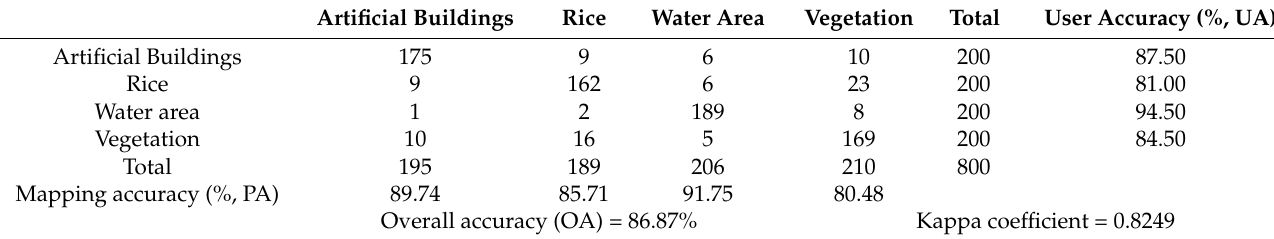
Table 9. Classification accuracy of time-series SAR and coherence coefficients.